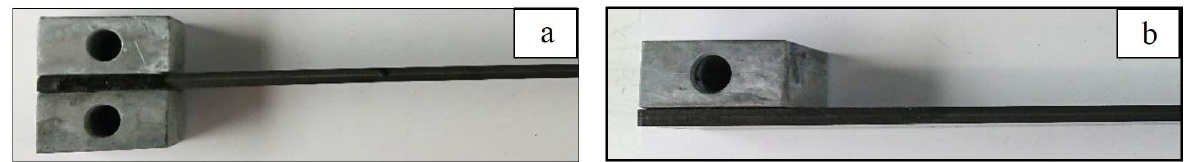
Figure 2. Loading block configuration for ( a ) DCB and ( b ) ELS